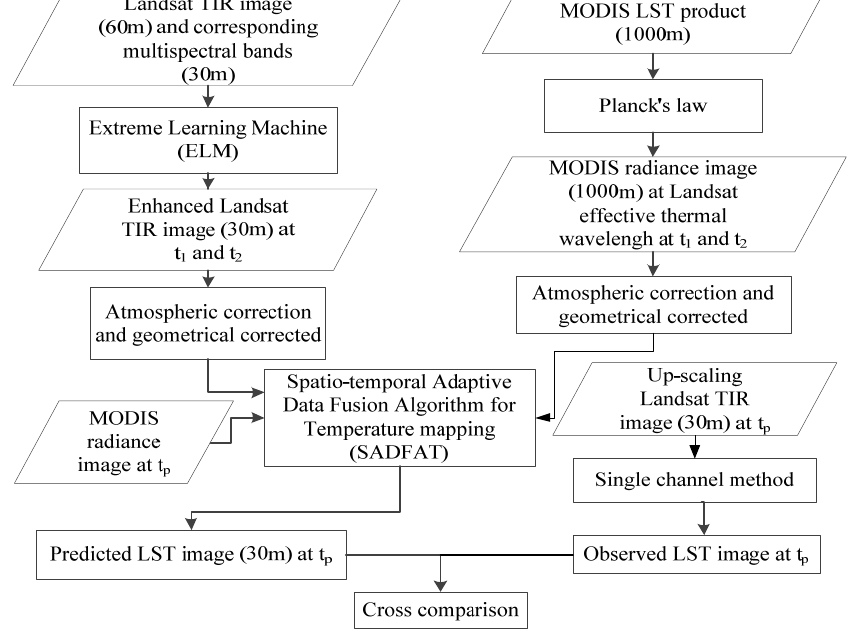
Figure 2. Flowchart of the proposed fusion model for predicting synthetic LST image at 30 m